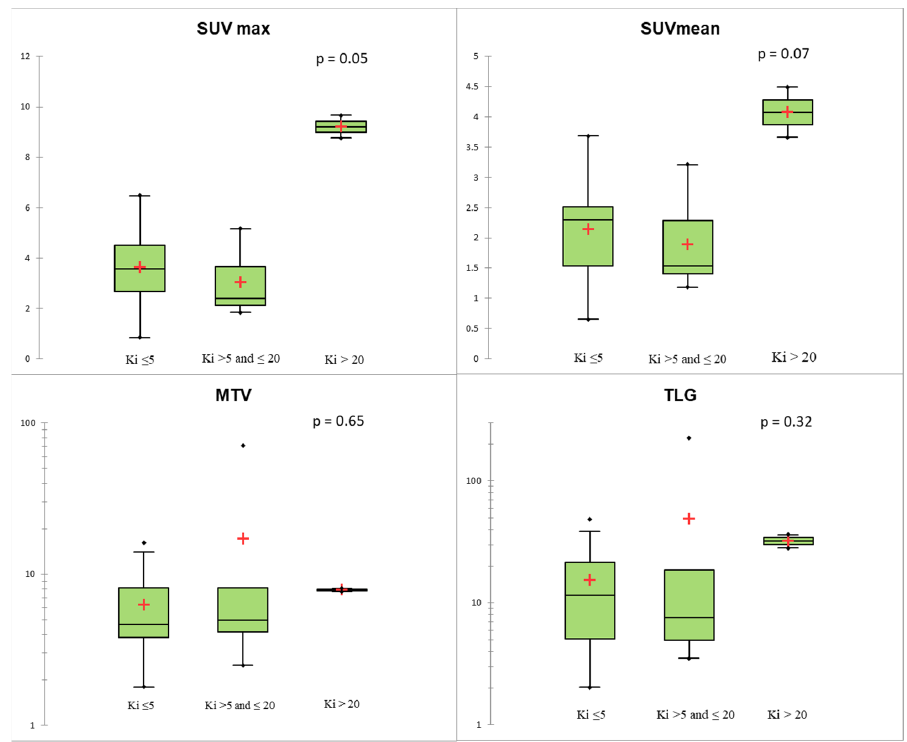
Figure 3. Conventional and volumetric parameters according to Ki-67 level using the Kruskal–Wallis test. The red crosses correspond to the mean value. The central horizontal bars correspond to the median value. The lower and upper limits of the boxes are the first and third quartiles. The error bars are the first decile and the ninth decile; the rhombuses are the minimum and maximum for each parameter.